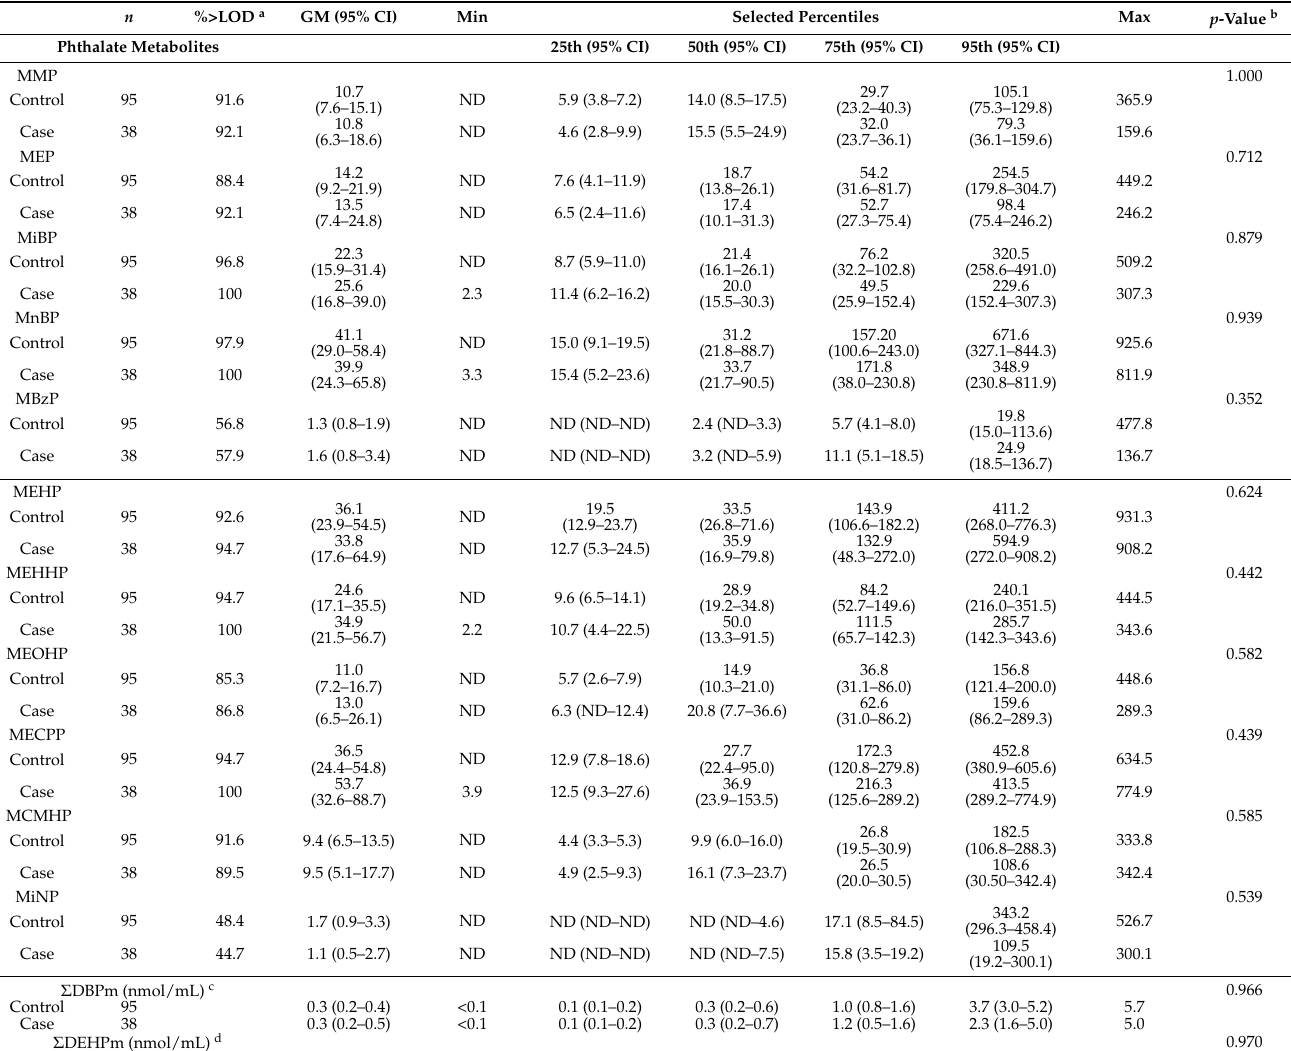
Table 2. Levels of urinary phthalate metabolites (ng/mL) for control and case